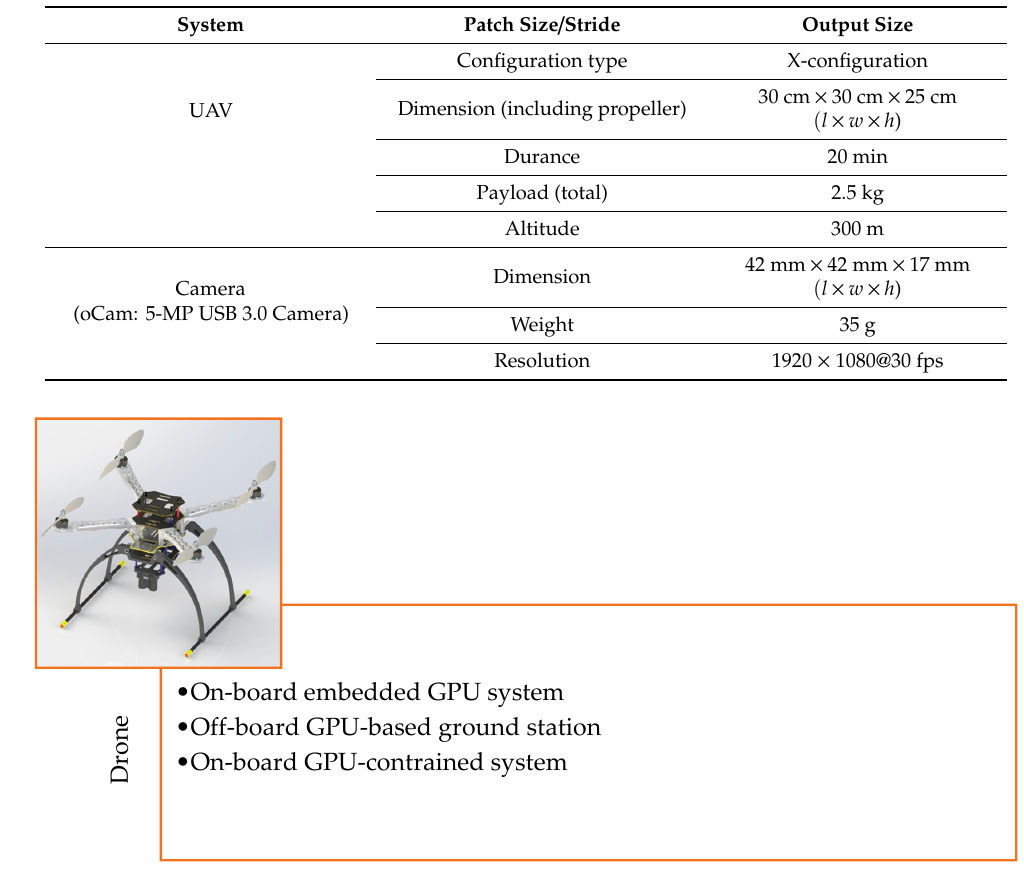
Figure 2. List of developed embedded system types for the aerial vehicle.